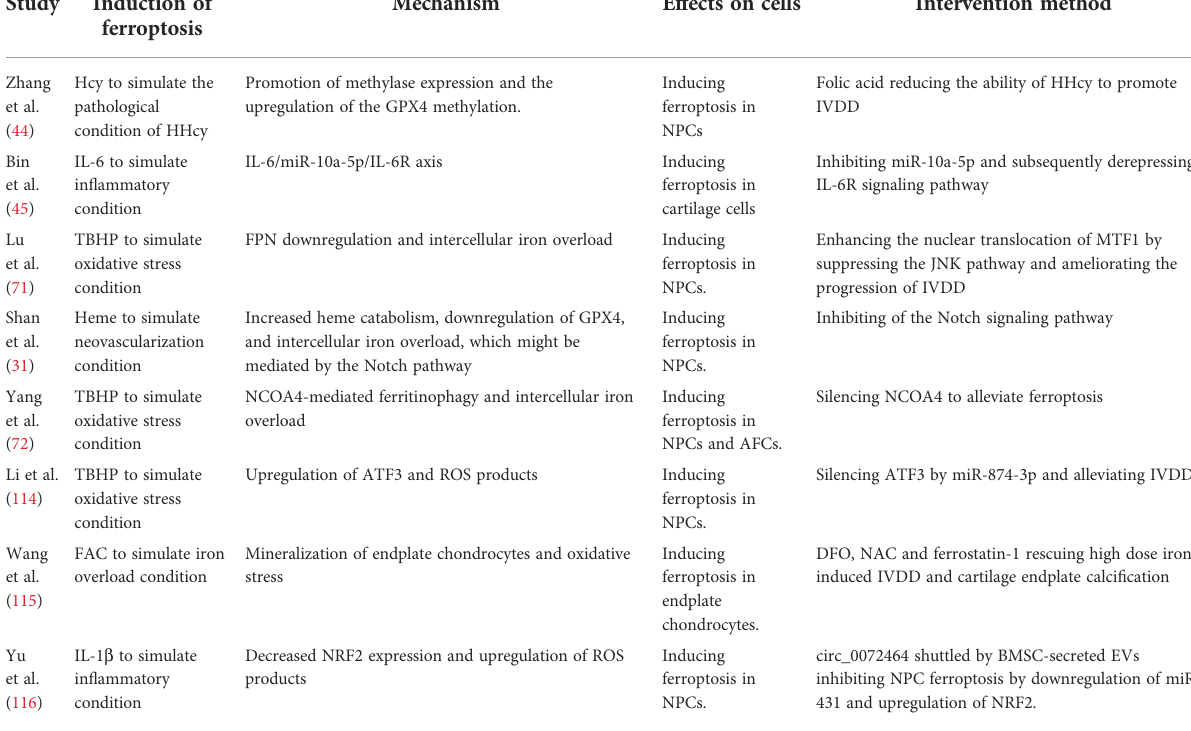
TABLE 1 Mechanism and intervention methods of ferroptosis in